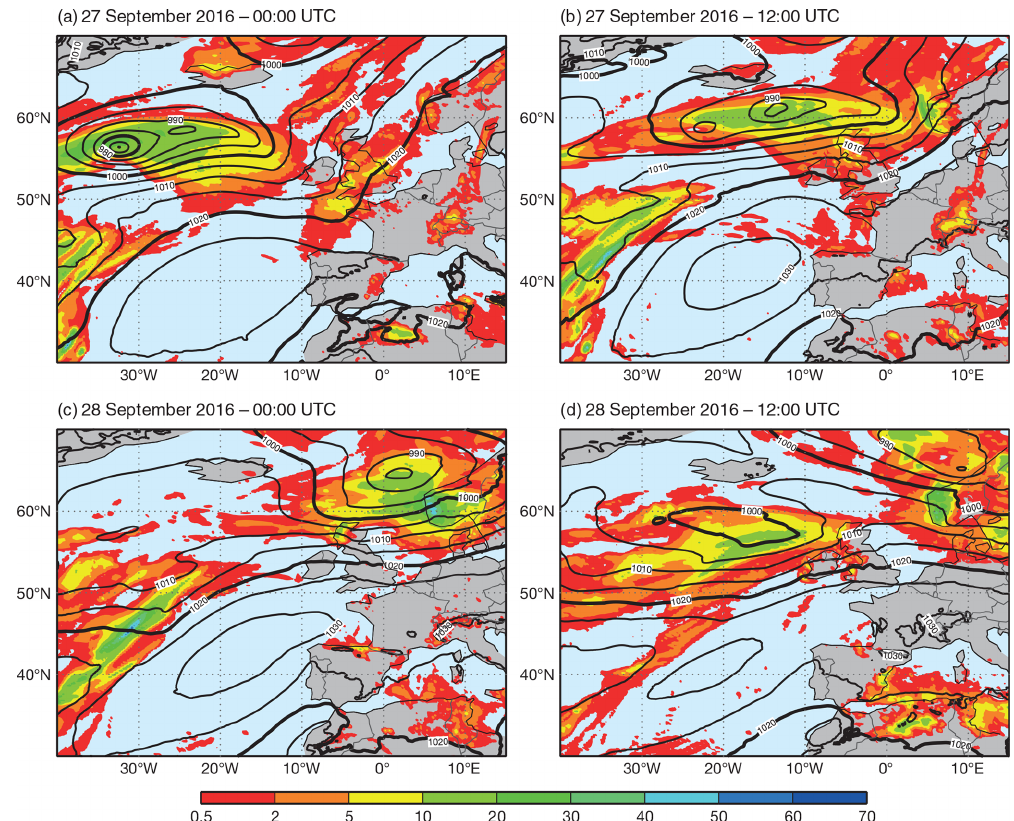
Figure 1. Evolution of Tropical Cyclone Karl on 27 and 28 September 2016 showing the downstream impact with heavy rainfall over western Norway. Contour lines display mean sea level pressure (hPa) from the ECMWF operational analysis. Colour shading shows the 12-hourly accumulated total precipitation (mm) from the ECMWF operational